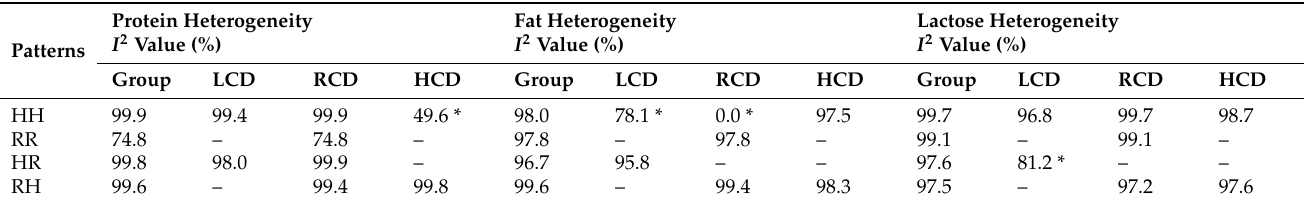
Table 3. Values of subgroup with the carbohydrates.